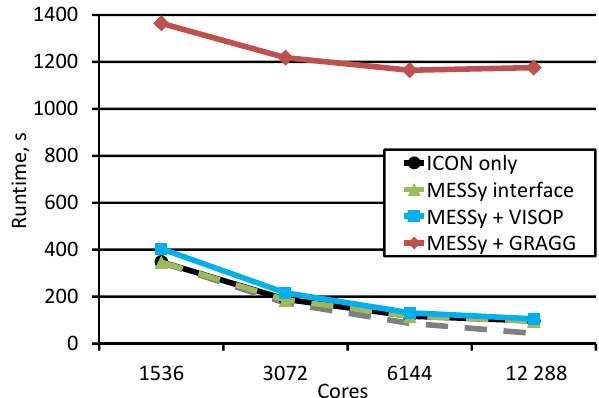
Figure 5. As Fig. 4 with output activated for ICON and the sub- models.